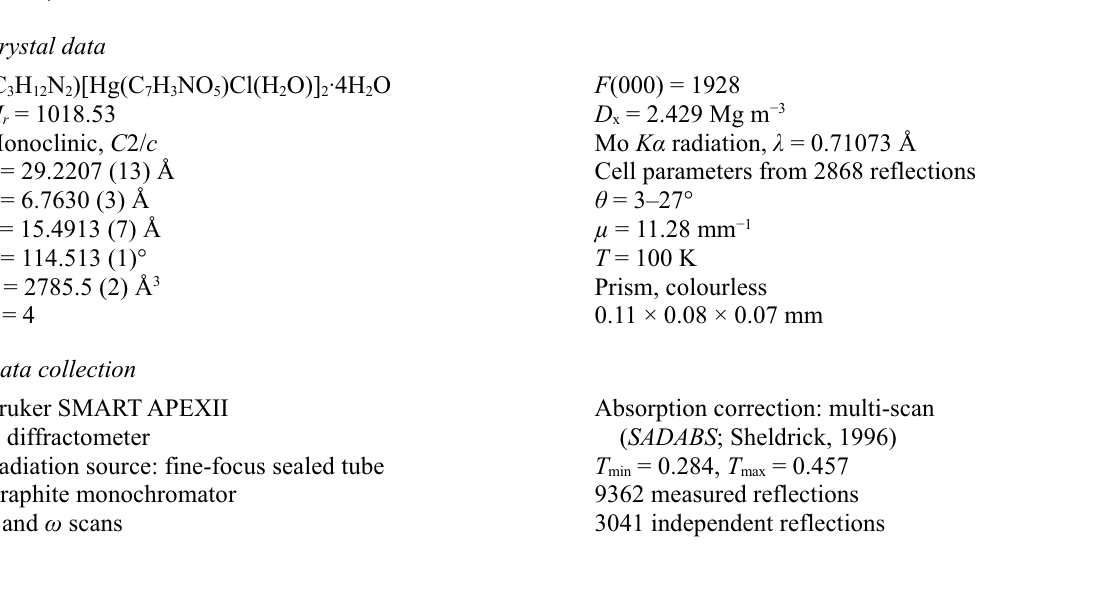
Figure 2 The crystal packing of the title compound viewed down the b axis, hydrogen bonds are shown as dashed lines. Propane-1,3-diammonium bis[aquachlorido(4-hydroxypyridine-2,6- dicarboxylato- κ 3 O 2 , N , O 6 )mercurate(II)]